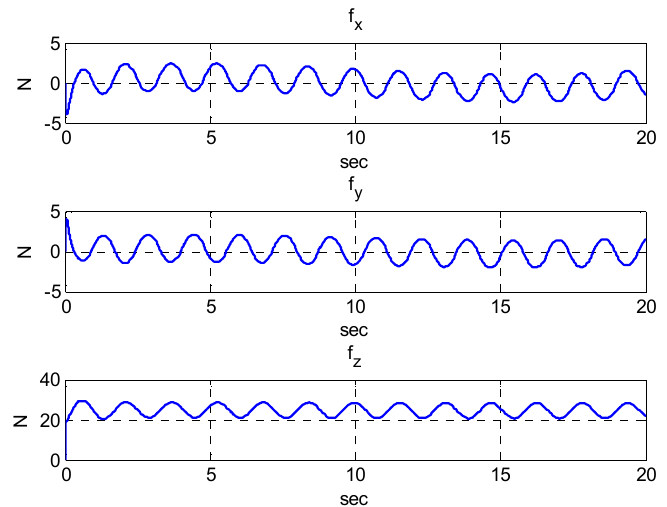
Figure 11. The propelling force with variable deviations and perturbations.